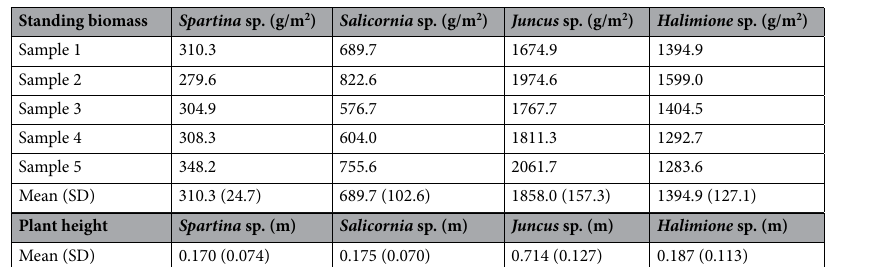
Table 1. Standing biomass (g/m 2 ) and plant height (m) for the four species. Sample 1: 5 boxes from the field; Sample 2: 5 boxes at the leading edge of the meadow in the first cut; Sample 3: 5 boxes at the central part of the meadow in the first cut; Sample 4: 5 boxes at the leading edge of the meadow in the second cut; Sample 5: 5 boxes at the central part of the meadow in the second cut. The mean value and standard deviation (SD) of the standing biomass and plant height are displayed.